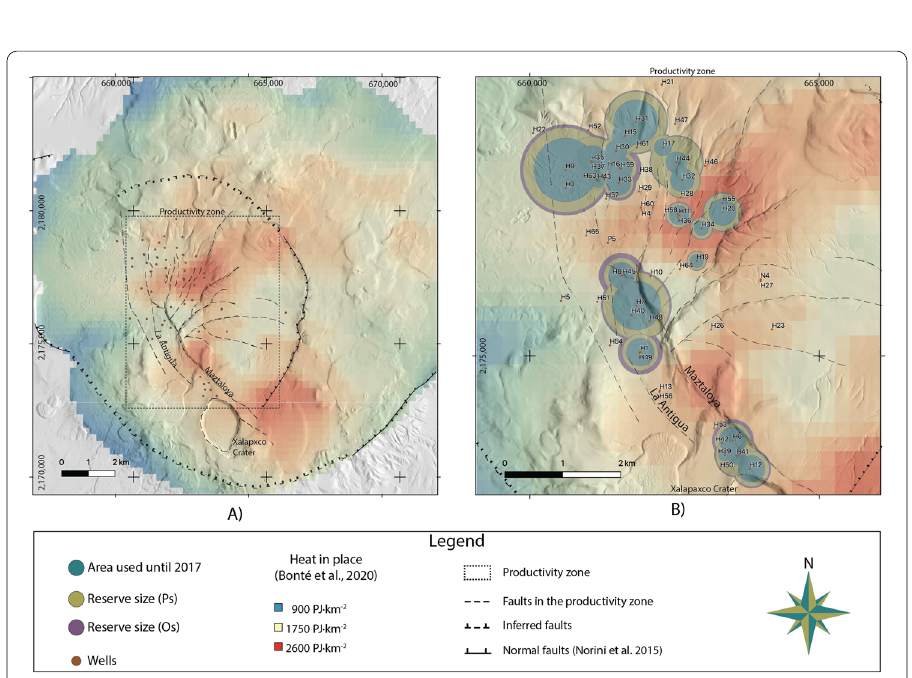
Fig. 6 a Full extension of the Los Humeros caldera color indicating the density of the heat in place (Bonté et al. 2020). b Resulting area affected by the